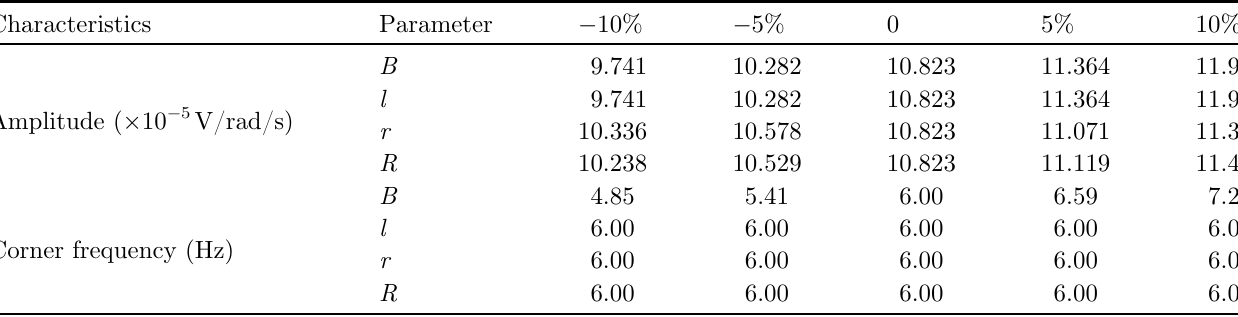
Table 2. Amplitude and corner frequency changing to parameter alteration. Characteristics Parameter